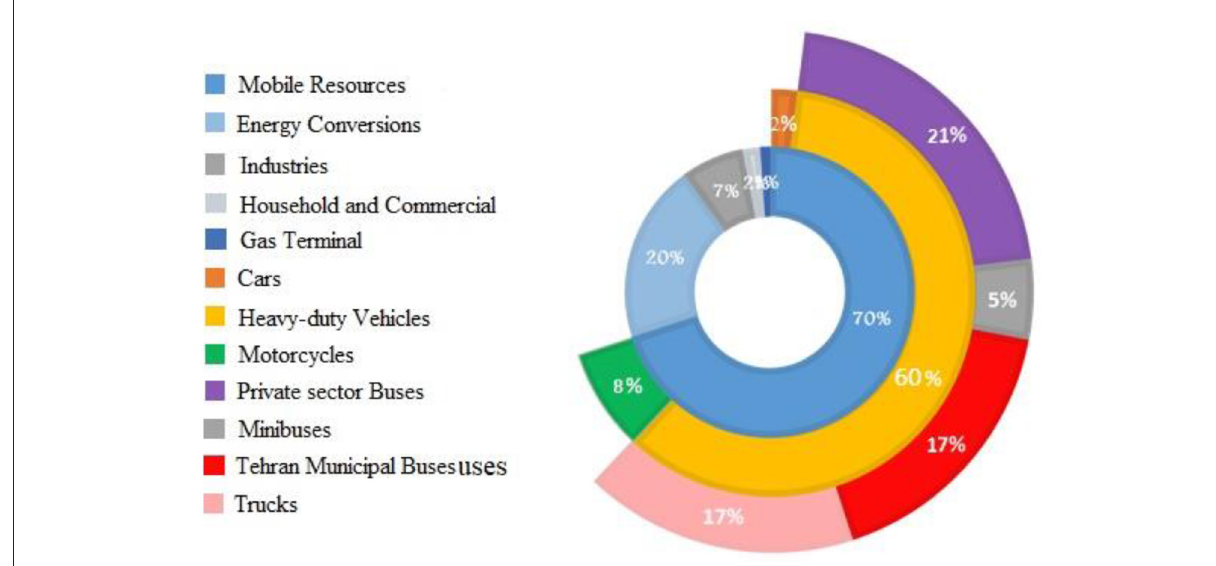
FIGURE3 The contribution of the mobile and stationary sources for PM pollution emission in Tehran.